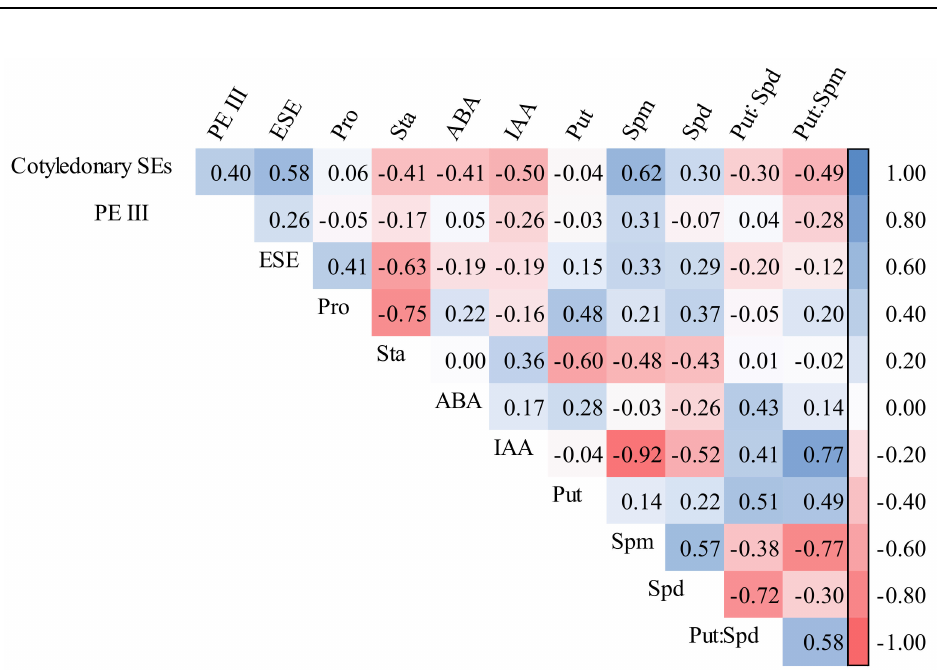
Figure 15. Correlations between SE yield and morphological and physiological indicators of P. koraiensis cell lines. The numbers in the figure are correlation coefficients (R-values); the larger the R-value, the more significant the